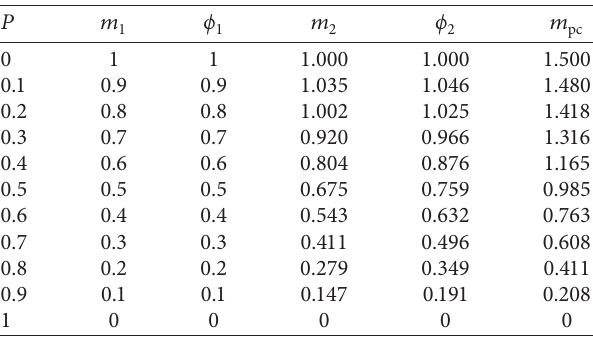
Table 3: Dimensionless parameters of steel column cross sections.